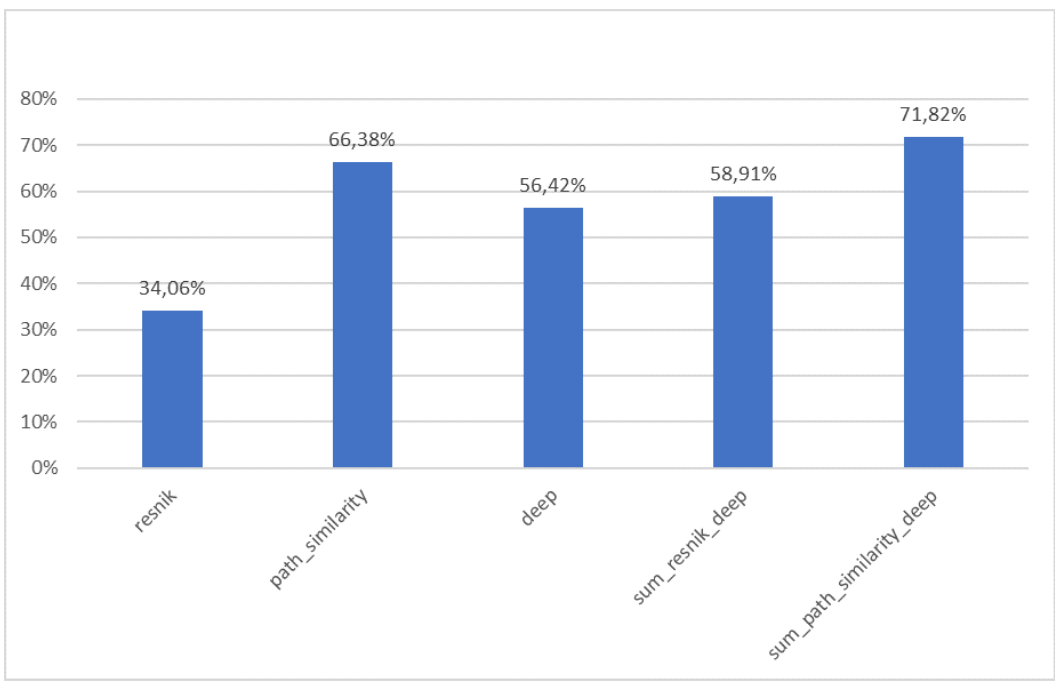
Figure 16. MAP@10